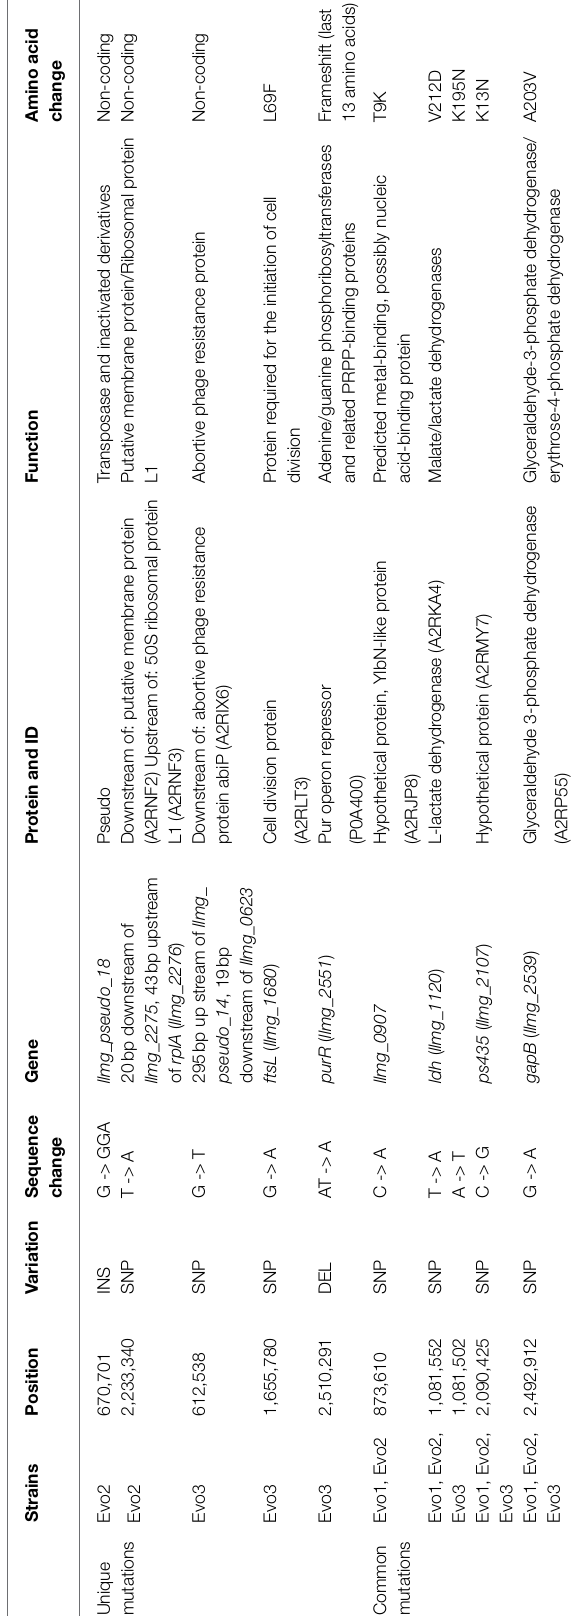
TABLE 2 | Numbers of differentially produced proteins in the evolved strains compared to MG1363 under different cultivation conditions. No. of